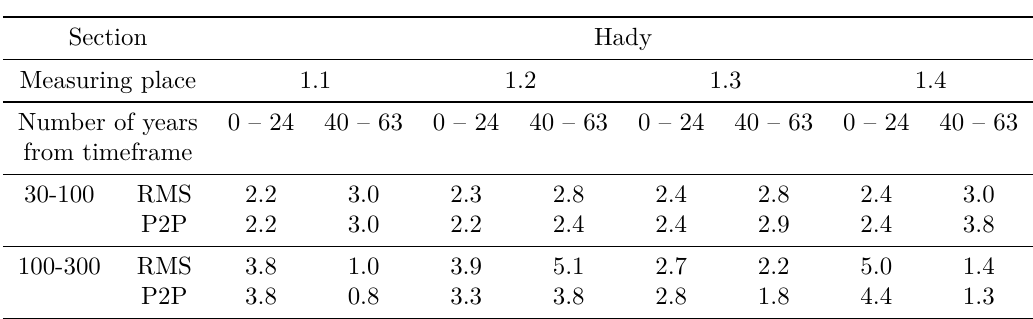
Table 4. Number of years needed to reach the wave defect progression of the same level as before the rails were ground.